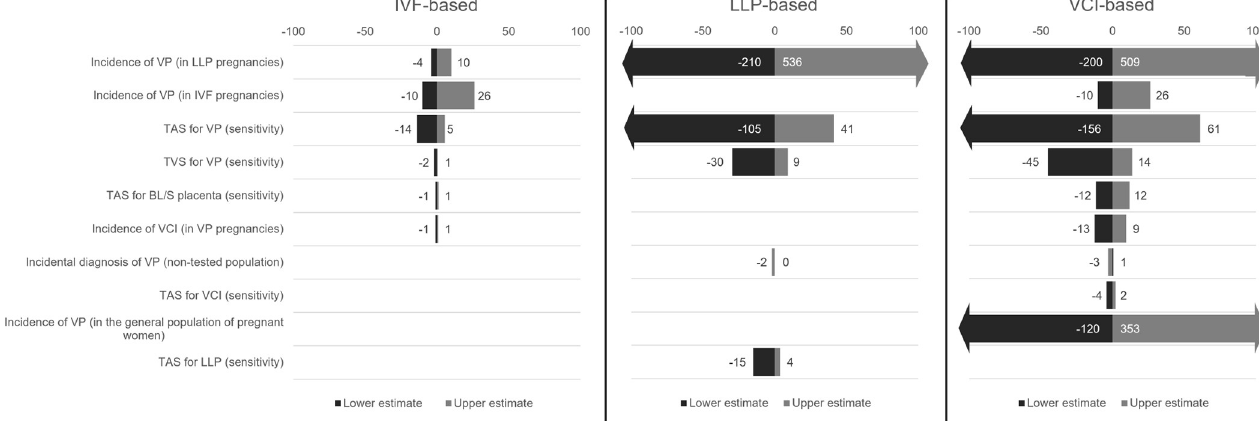
Fig 3. Results of the DSA for the number of diagnosed VP cases. Upper estimate demonstrates the impact on the difference between each pathway and the no screening pathway in terms of diagnosed VP pregnancies by increasing the variable; lower estimate demonstrates the impact on the number of diagnosed VP pregnancies by decreasing the variable. Asymmetric bars are indicative of input values already being close to the ceiling value for the input type (for example, a probability of 0.9) and therefore being unable to be increased to the full extent. Abbreviations: BL/S, bilobed or succenturiate; DSA, deterministic sensitivity analysis; IVF, in vitro fertilisation; LLP, low-lying placenta; TAS, transabdominal sonography; TVS, transvaginal sonography; VCI, velamentous cord insertion; VP, vasa